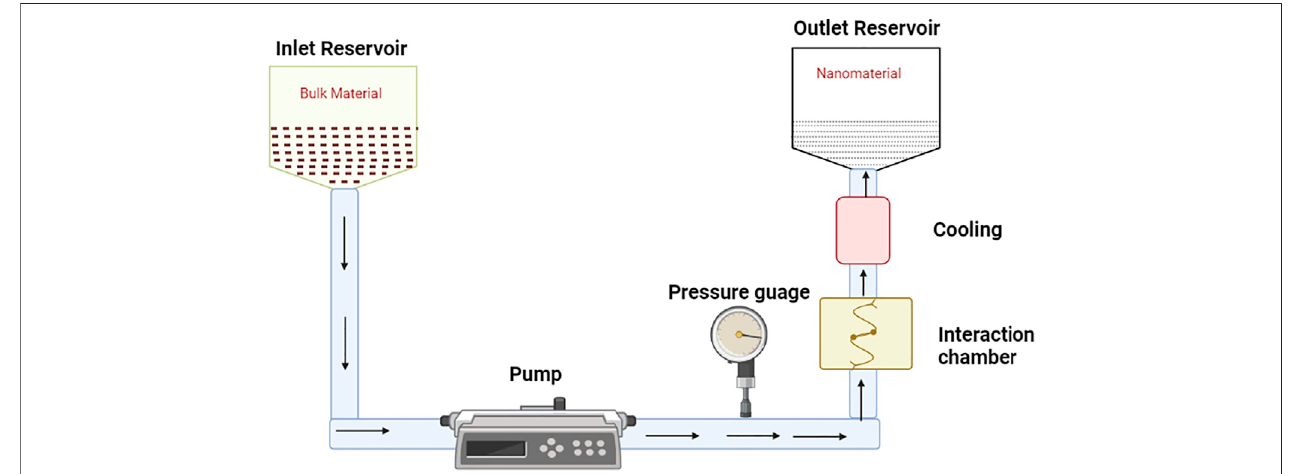
FIGURE 3 | Different hydrolysis methods for the production of cellulose nano fi